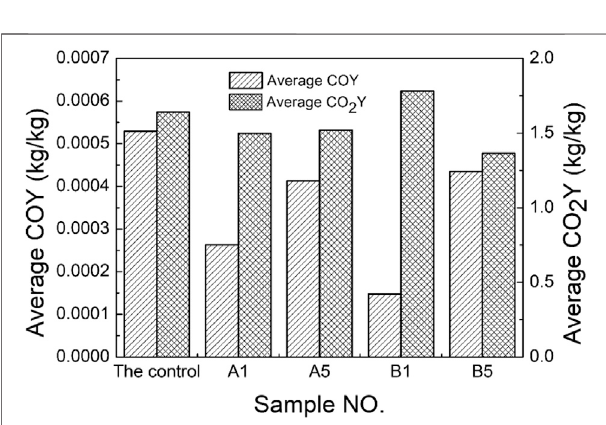
FIGURE10| AverageCOYandCO 2 Yofbamboospecimensbeforeand after LbL self-assembly with PA-PEI.